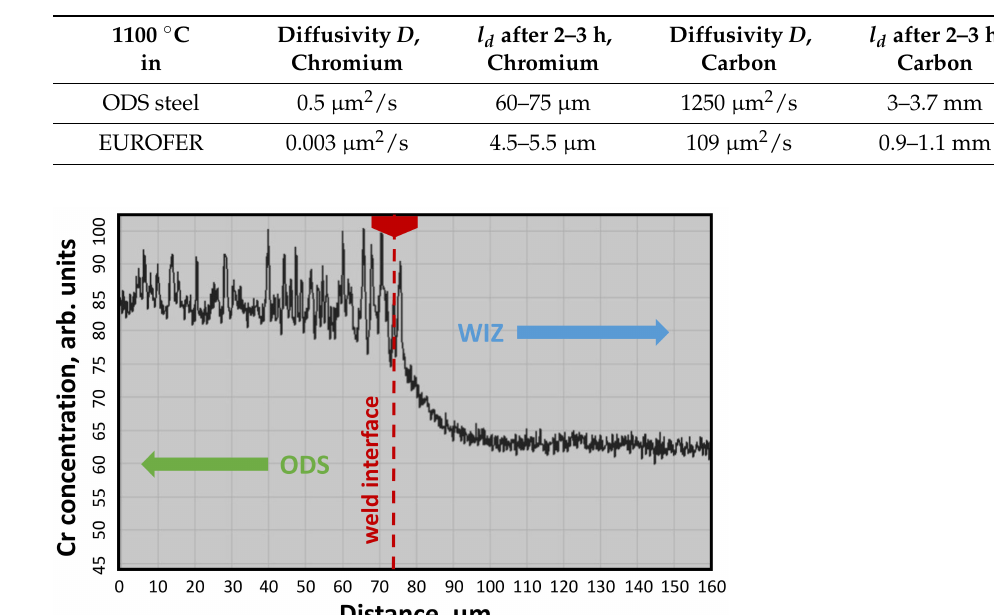
Table 7. Estimated diffusion lengths and diffusivity values for chromium and carbon in EUROFER and 13% Cr ODS steel at 1100 ◦ C according to Equations (1) and (2). Note: At this temperature, EUROFER steel is in the austenitic phase. For chromium diffusion in ferrite and austenite, D 0 of 0.15 and 1.11 × 10 − 7 m 2 /s, and for F /( kT ) values of 26.38 and 17.4 were used. For carbon diffusion in ferrite and austenite, D 0 of 0.02 cm 2 /s, and for F /( kT ) values of 7.38 and 9.8 were applied (see [45–47]).